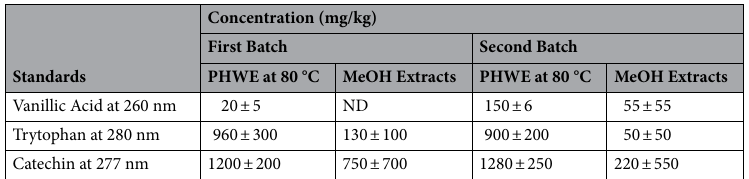
Table 1. Comparison of amount of vanillic acid, tryptophan and catechin present in two different batches of avocado seed extracted using PHWE at 80 °C (n = 6) and methanol (n = 3).